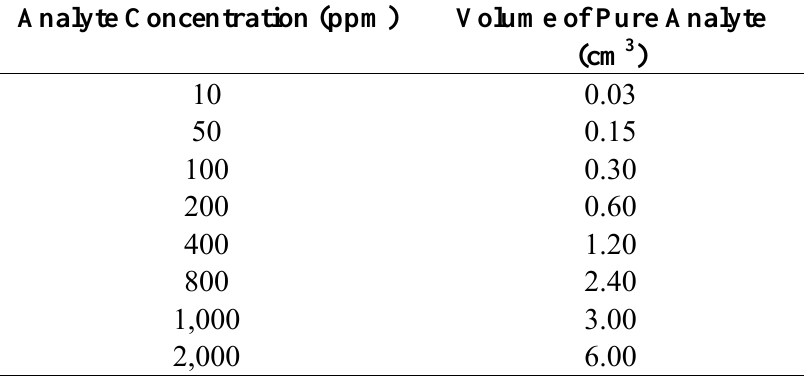
Table 1. Analyte concentration vs. analyte